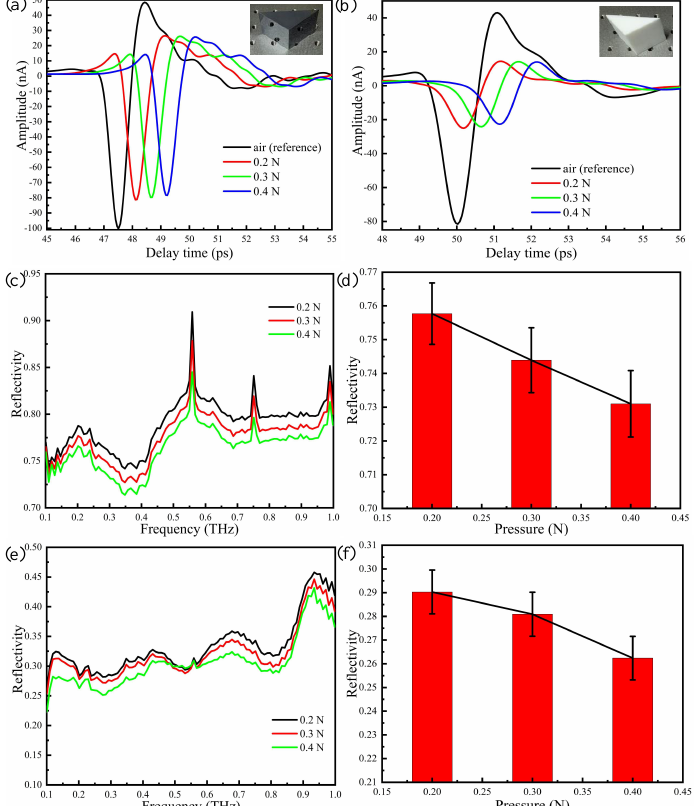
Figure 7. THz-ATR spectra with different different prisms: ( a ) the time domain spectra: silicon; ( b ) the time domain spectra: Teflon; ( c ) the reflection spectra: silicon; ( d ) error tree diagram of the reflectance at 0.3 THz: silicon; ( e ) the reflection spectra: Teflon; ( f ) error tree diagram of the reflectance at 0.3 THz: